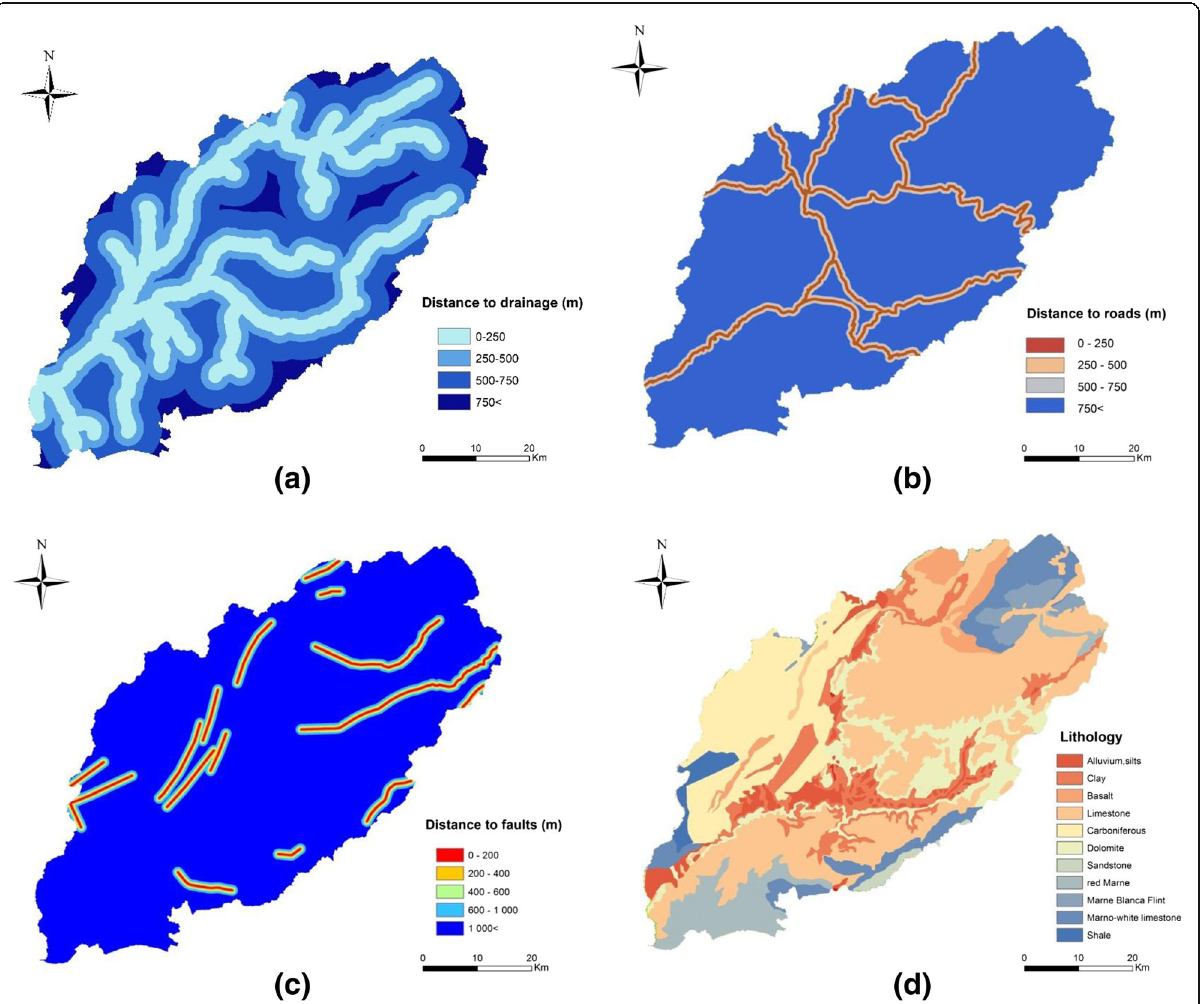
Fig. 3 Landslide contributing-factor layers produced for the study area: ( a ) distance to drainage network, ( b ) distance to roads, ( c ) distance to faults, ( d )